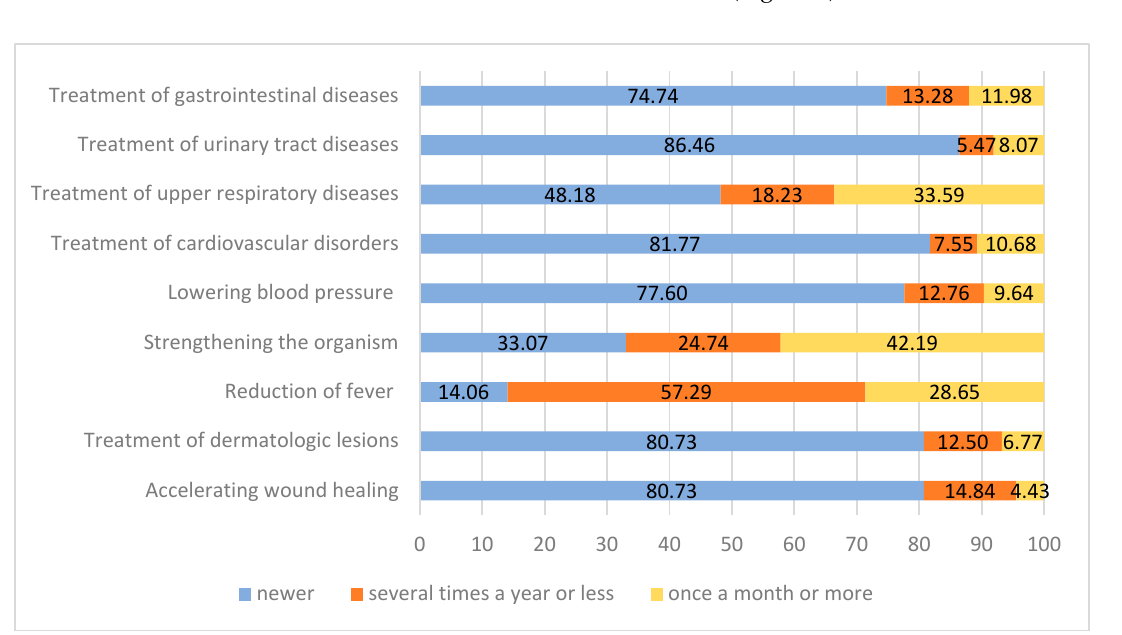
Figure 4. Purposes of cosmetic use of honey (n = 209, data in %).